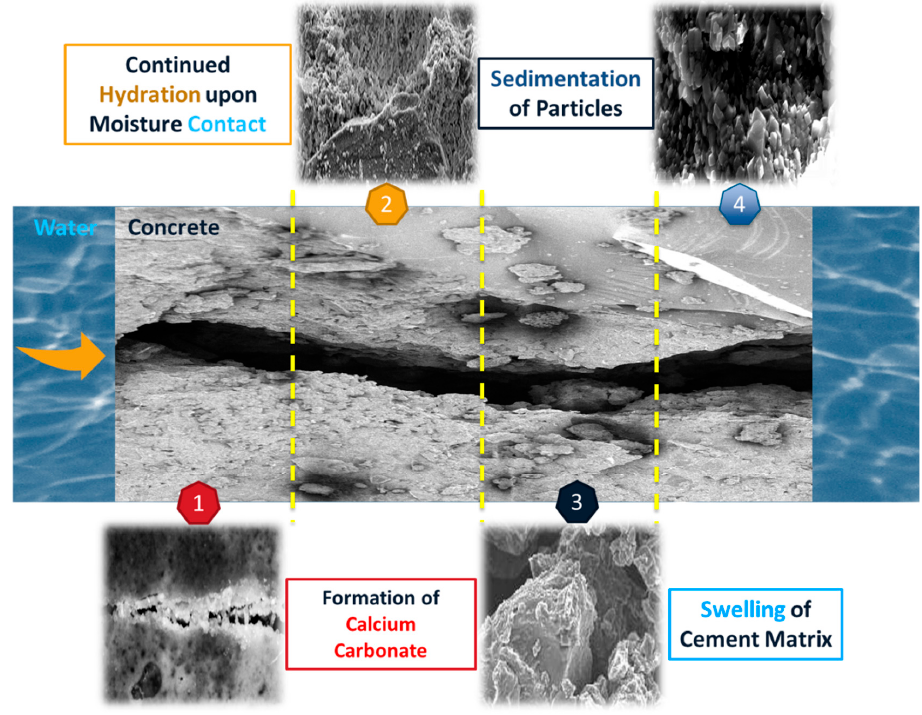
Figure 1. Self-healing mechanisms in concrete.